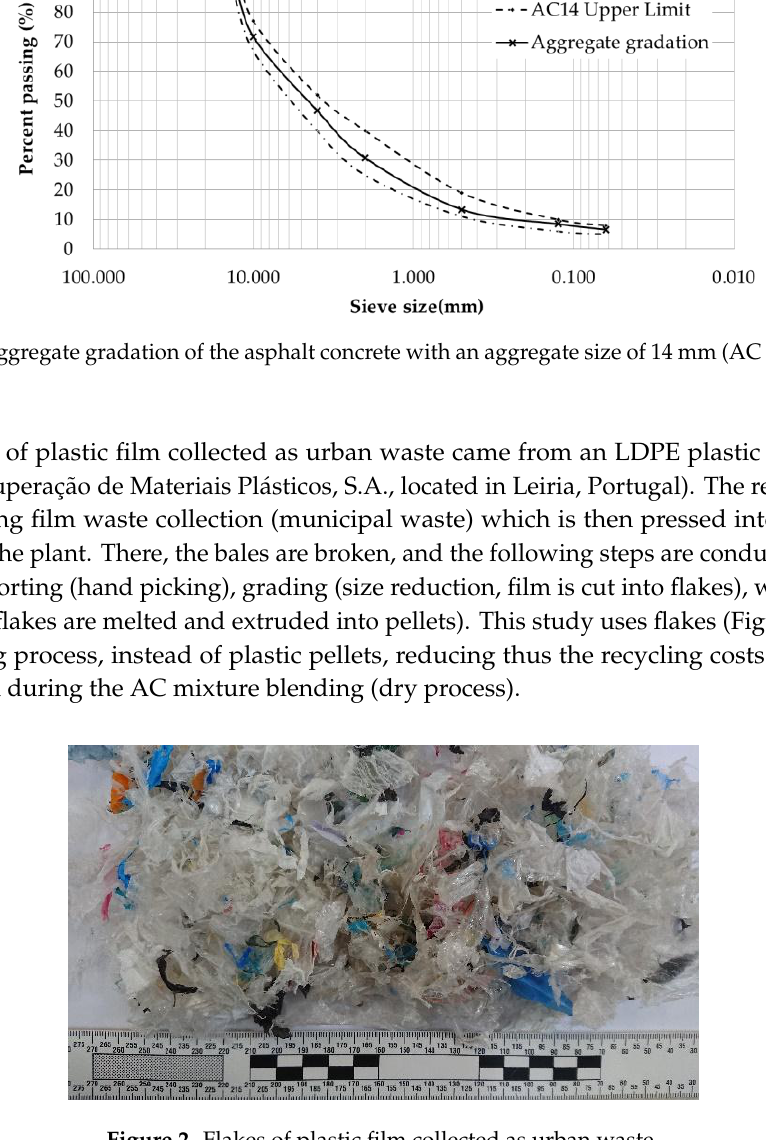
Figure 2. Flakes of plastic film collected as urban waste.